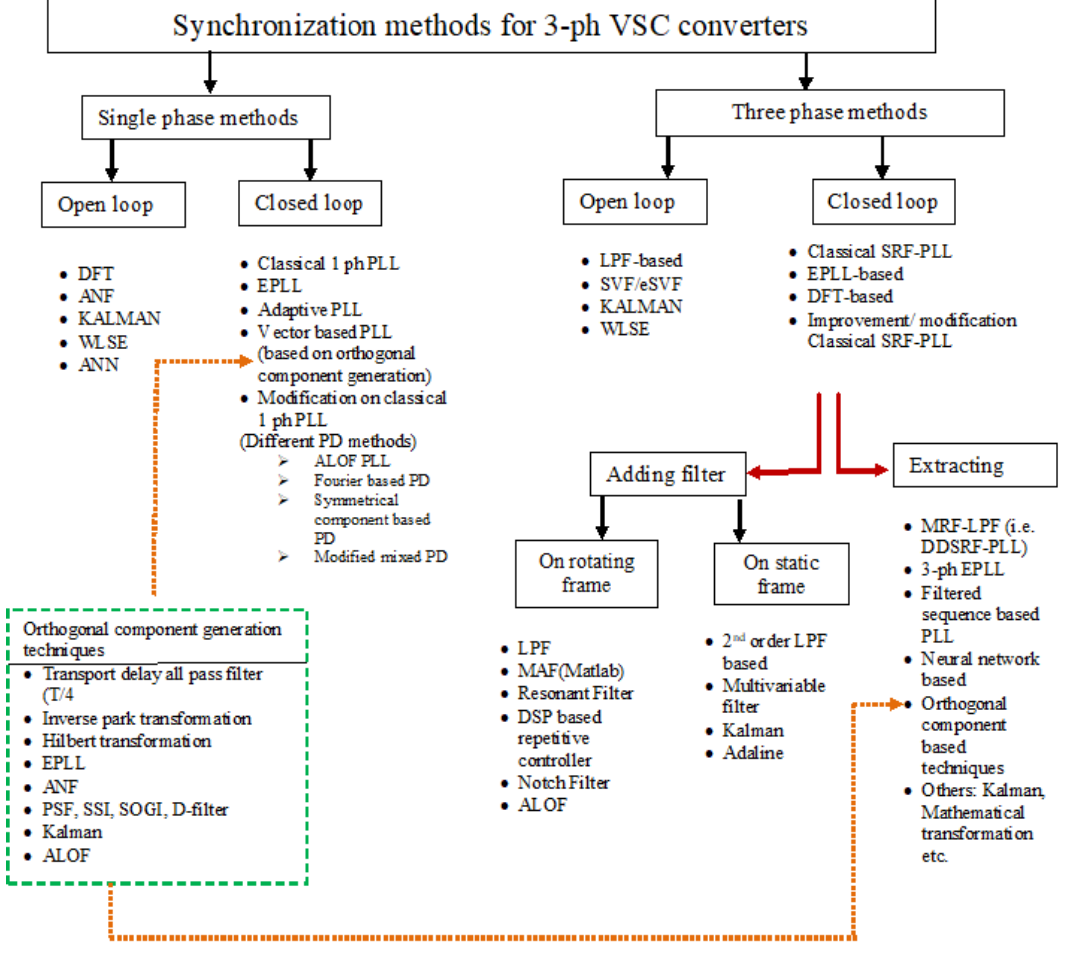
Figure 14. PV-Grid Synchronization methods. Reproduced from [70], 14th European Conference on Power Electronics and Applications (EPE): 2011.